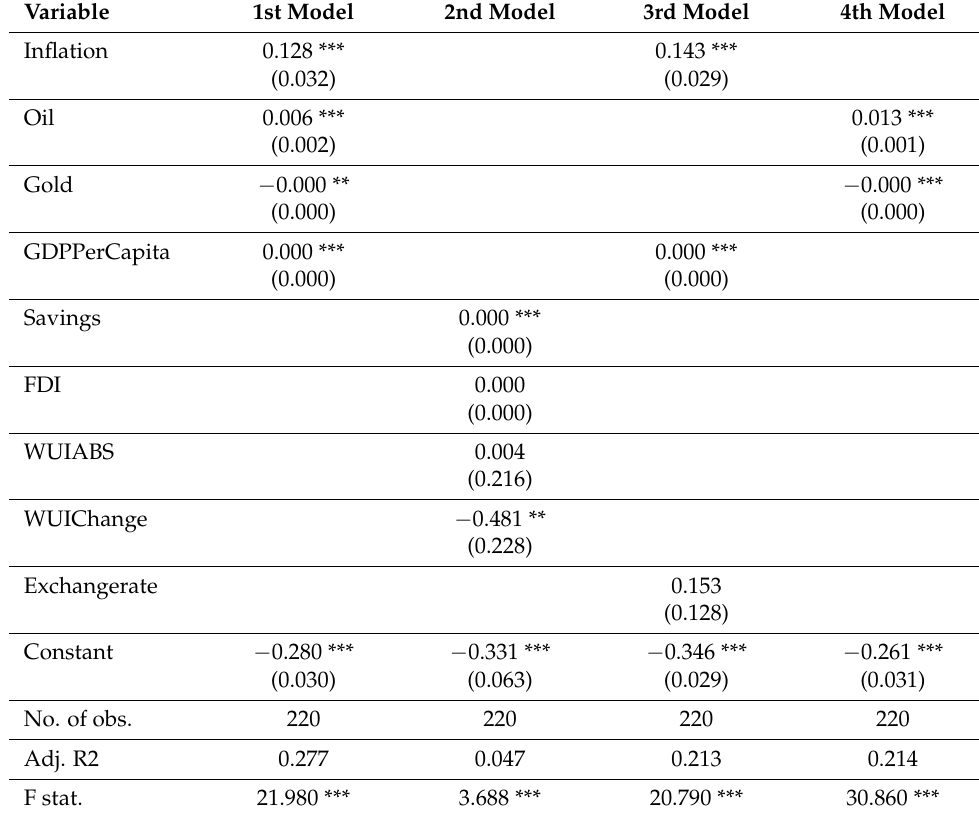
Table 2. The final view of regression models.